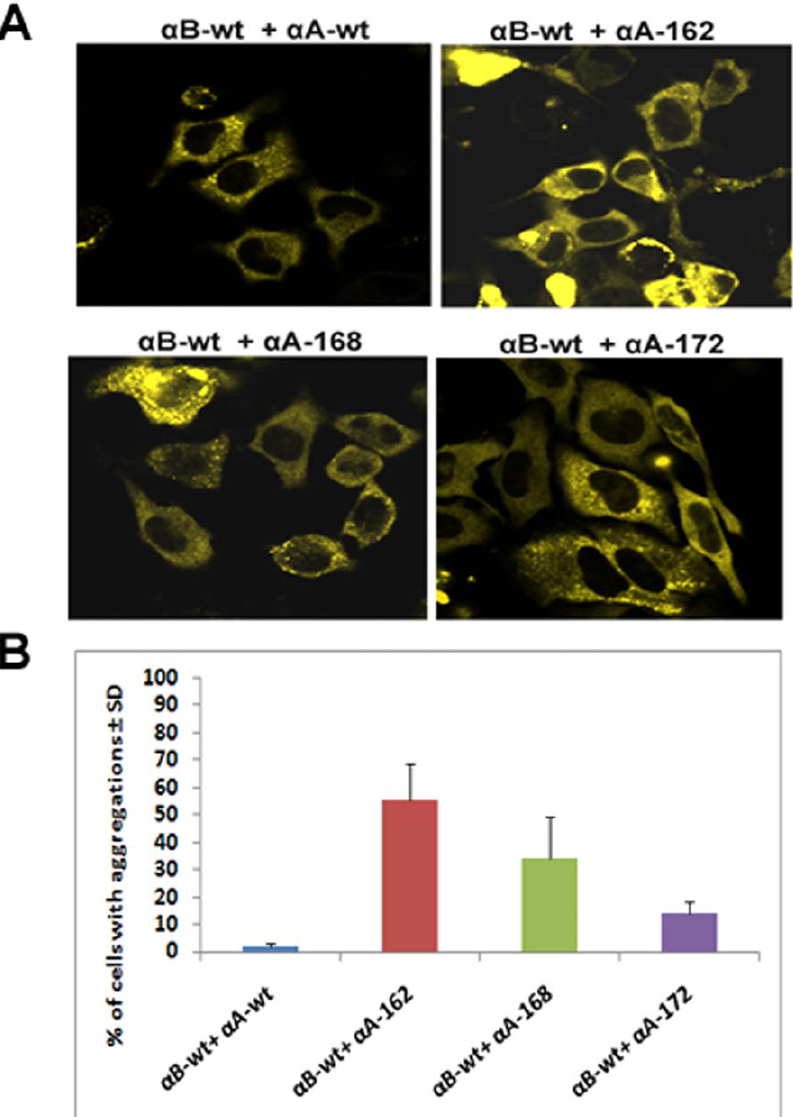
Figure 5. Co-expression of CFP-tagged a B-Crystallin wild-type with YFP-tagged a A-Crystallin wild-type and truncated constructs. A: LSM confocal images of human CFP a Bwt co-expressed with YFP a Awt and YFP-C-terminal truncated a A-crystallins in HeLa cells . CFP was excited at 458 nm and the images were collected by BP 475–525 nm filter, YFP was excited at 514 nm and the images were collected by BP 530–600 nm filter. B: Bar diagram showing the percent of cells containing aggregates (from fig. 5A) . The values were determined as in fig. 1B. The mean values are statistically significant at p , 0.05 for a Bwt + a A162 and a Bwt + a A172 Vs a Bwt + a Awt groups.